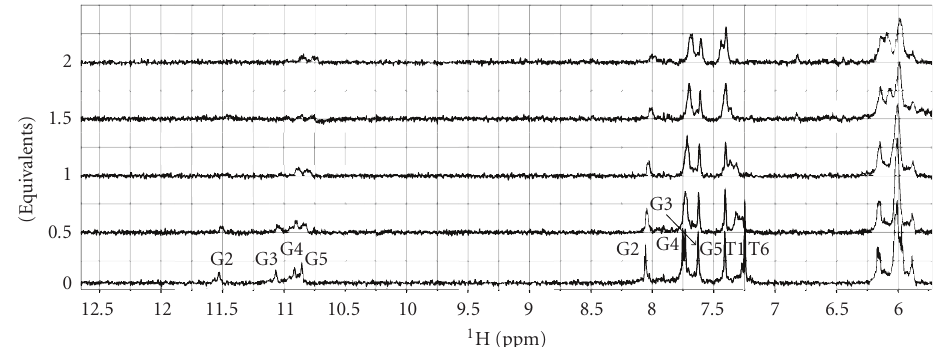
Figure 2: NMR titration of [d(TGGGGT)] 4 with derivative 1 (700MHz, T = 25 ◦ C). 2mM (8mM single strand concentration), in 0.2 ml (H 2 O/D 2 O 9:1) bu ff er solution having 10 mM KH 2 PO 4 , 70mM KCl, 0.2mM EDTA, and pH 7.0. Equivalents of the drug are reported on the left of each spectrum.